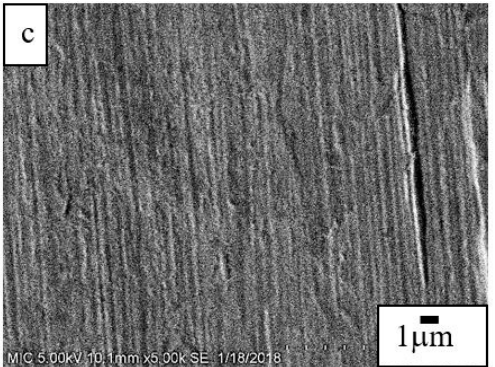
Figure 1. SEM images: ( a ) the superhydrophobic copper surface; ( b ) the superhydrophobic copper surface at higher magnification; ( c ) the pristine copper surface.